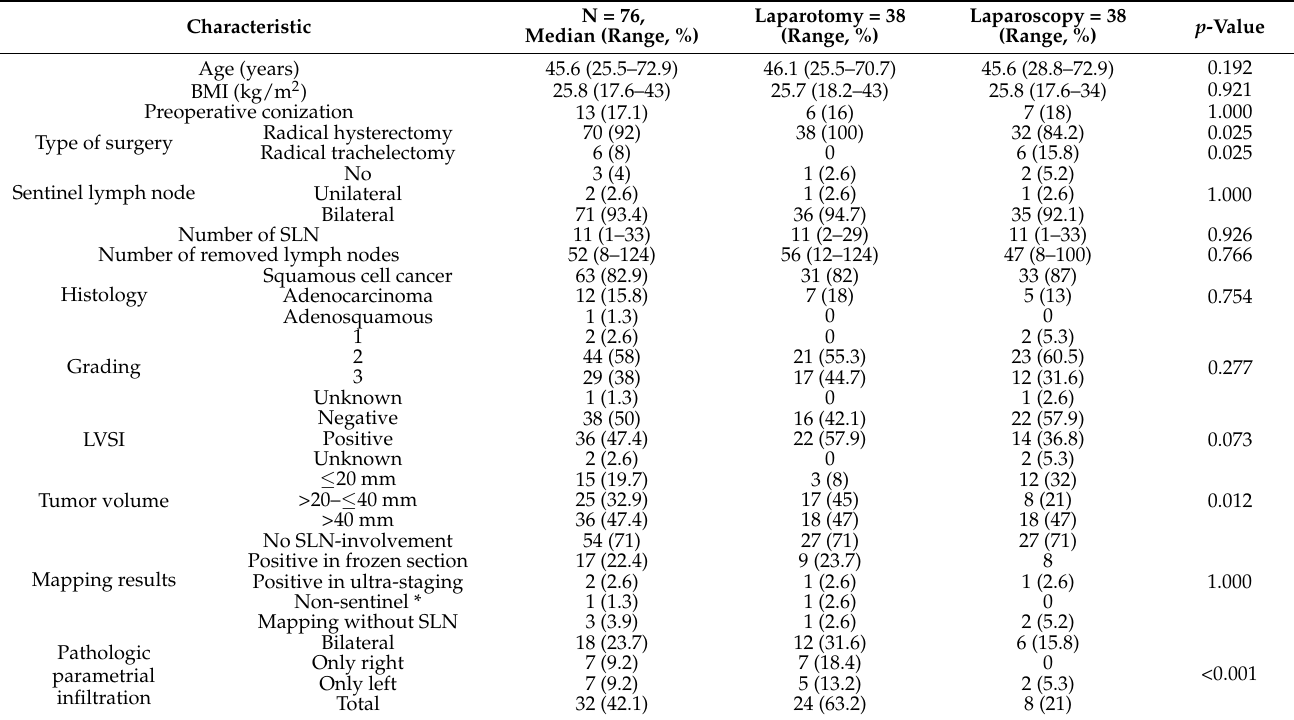
Table 1. Patients and tumour